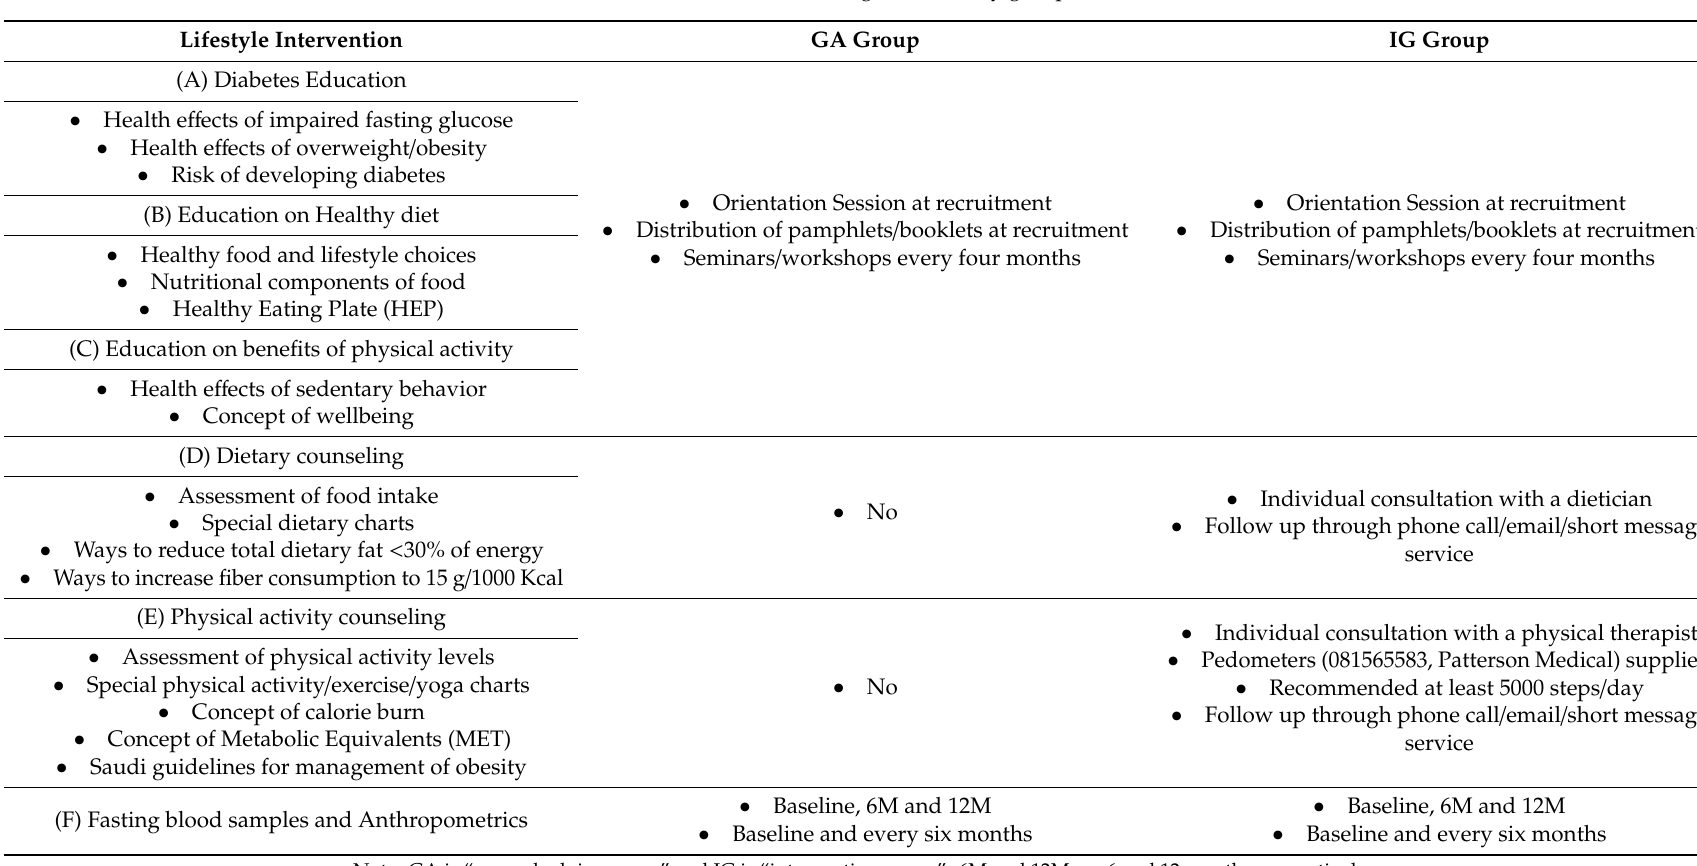
Table 1. Intervention given to study